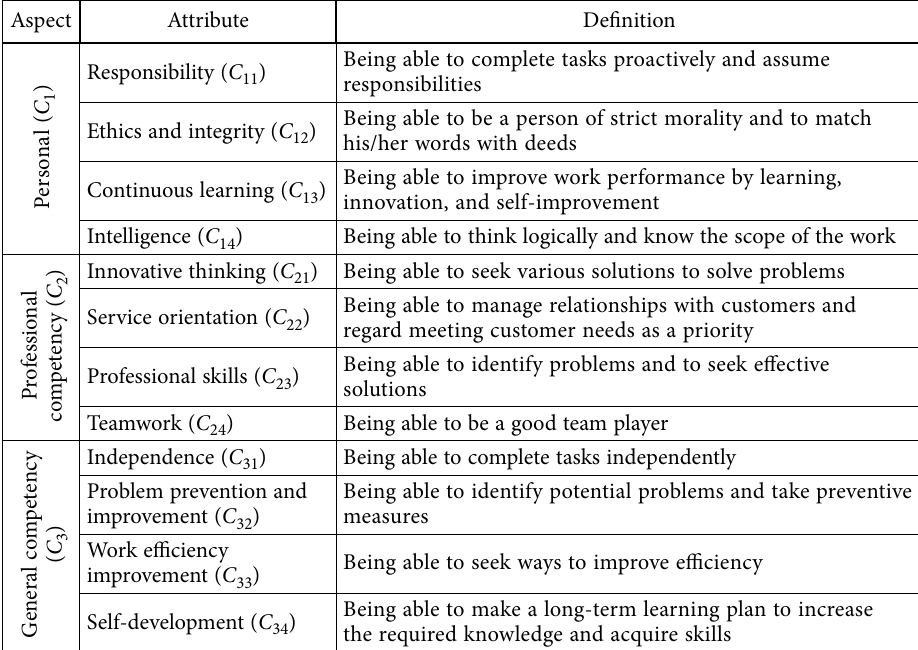
Table 2. Personnel evaluation aspects and